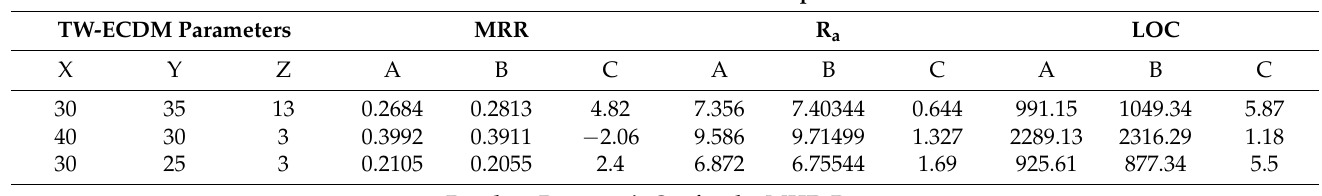
Table 10. Additivity test.